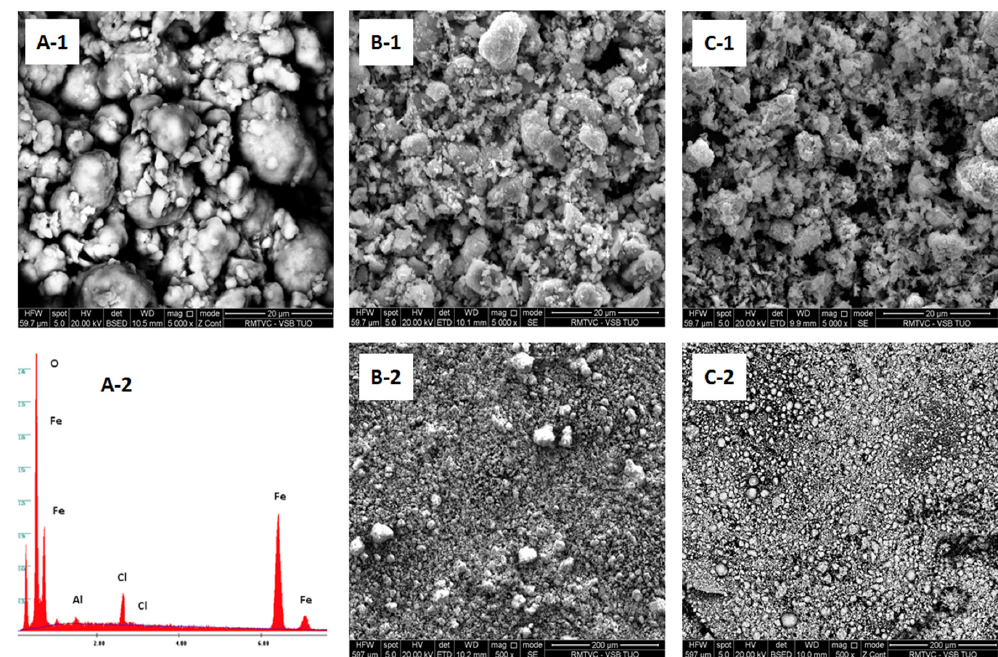
Figure 7. SEM/EDAX images of ( A - 1 ) original (WFS/0) with scale 20 µ m; ( A - 2 ) original (WFS/0) with EDAX analysis; ( B - 1 ) calcined at 180 ◦ C (WFS/180) with scale 20 µ m; ( B - 2 ) calcined at 180 ◦ C (WFS/180) with scale 200 µ m; ( C - 1 ) calcined at 900 ◦ C (WFS/900) with scale 20 µ m; ( C - 2 ) calcined at 900 ◦ C (WFS/900) with scale 200 µ m.